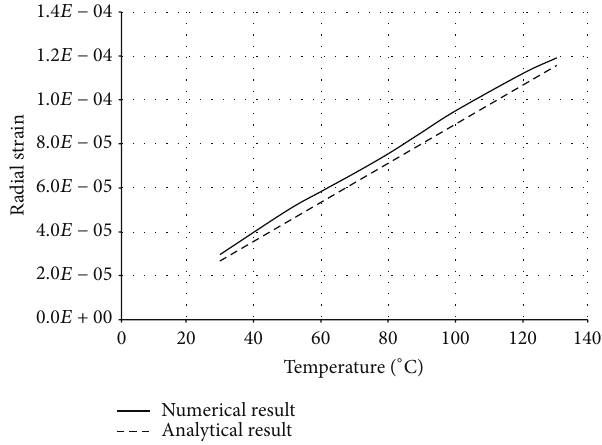
Figure 16: Comparison of tangential strain in steel core.